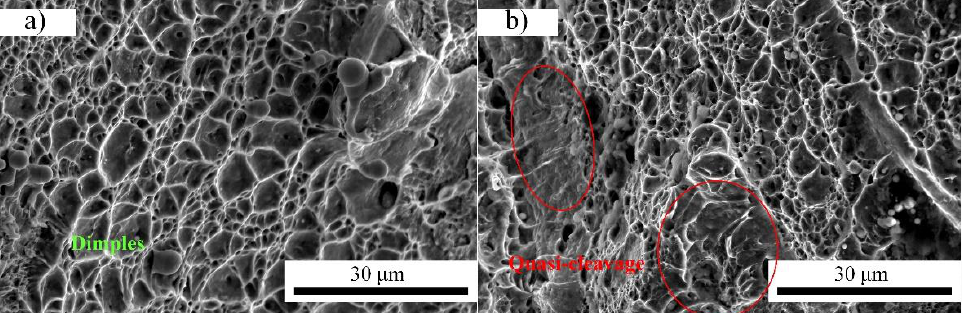
Figure 10. Slow-strain rate tensile fracture of samples B with and without hydrogen charging. ( a ) Not hydrogenated; ( b ) hydrogenated.